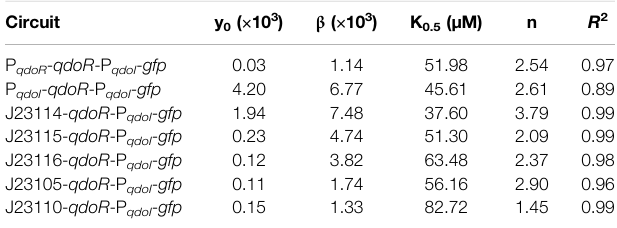
TABLE2| Data fi ttingfortheparametersofthecircuitsinducedbyquercetinusing Hill function.